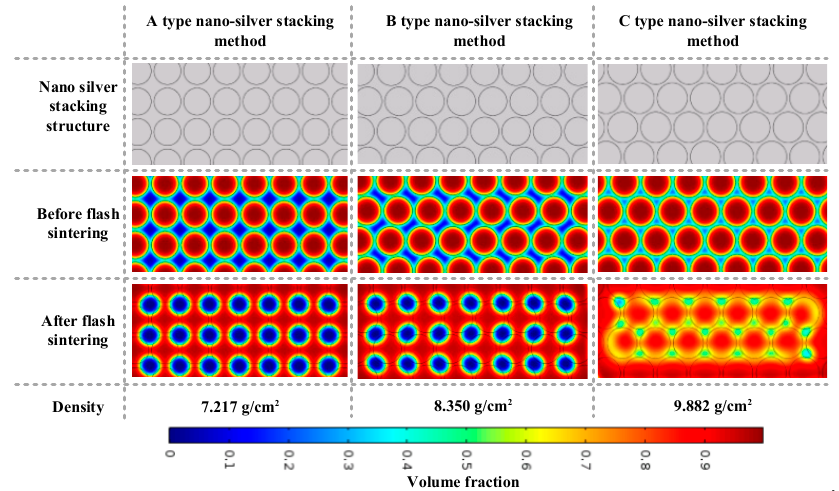
Figure 6. Model of multi-particle sintering at different densities.